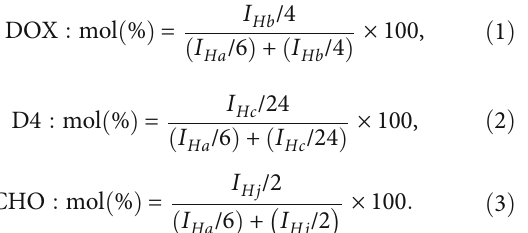
(cyclohexane CH ) is between 1.0- 2.0 ppm. Prominent 2 proton peaks ( H j at 1.40 ppm and H k at 1.28 ppm) have been marked in the fi gure. The proton peak of methine groups (CH -CHO) (H ) locates at 3.2 – 3.6 ppm [32], which 2 i